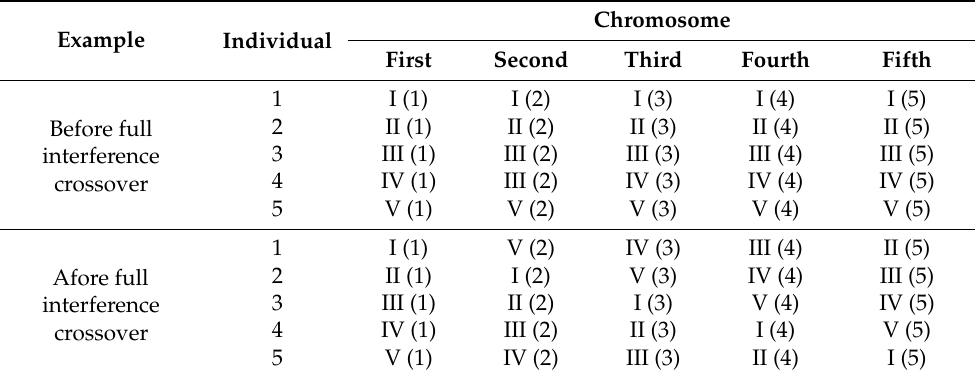
Table 3. Example of full-interference crossover operation.